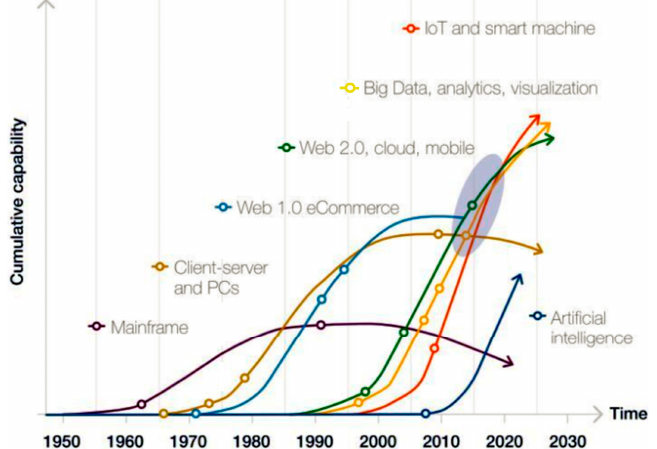
Figure 1. The trends in industrial digital information technologies in basic industries (Reprinted from Ref. [1]).